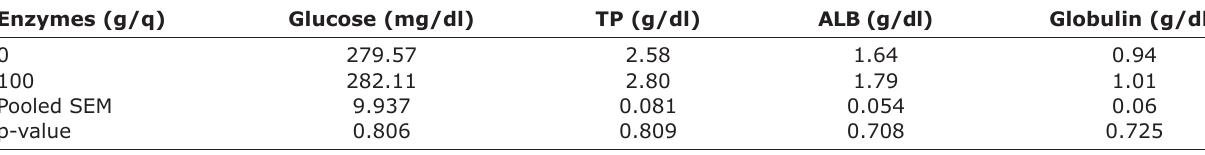
Table-5: Effect of feeding different levels of enzymes on the blood parameters of broiler. Enzymes